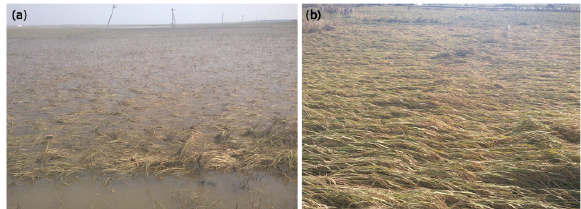
Figure 8. Field photographs of rice crop damage post cyclone ‘Titli’ (a) Pundi, Santabommali mandal on 16 October 2018 and (b) in Dasupuram, Pathapatnam mandal on 18 October 2018. Moreover, with the same ground observation, the flood-affected rice map was categorized into four classes namely Slightly damaged (<25% expected loss), moderately damaged (25%- 50% expected loss), severely damaged (50%-75% expected loss) and totally damaged (100%expected loss) and shown in Figs. 9 and 10.